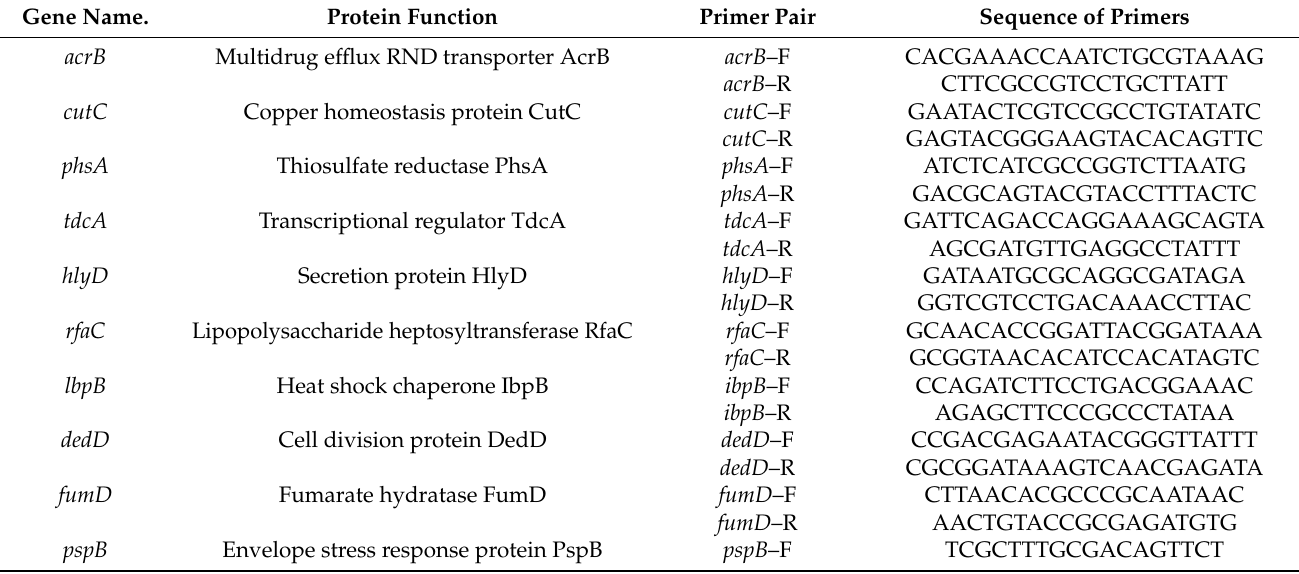
Table 3. Primers used for evaluation of proteomic iTRAQ